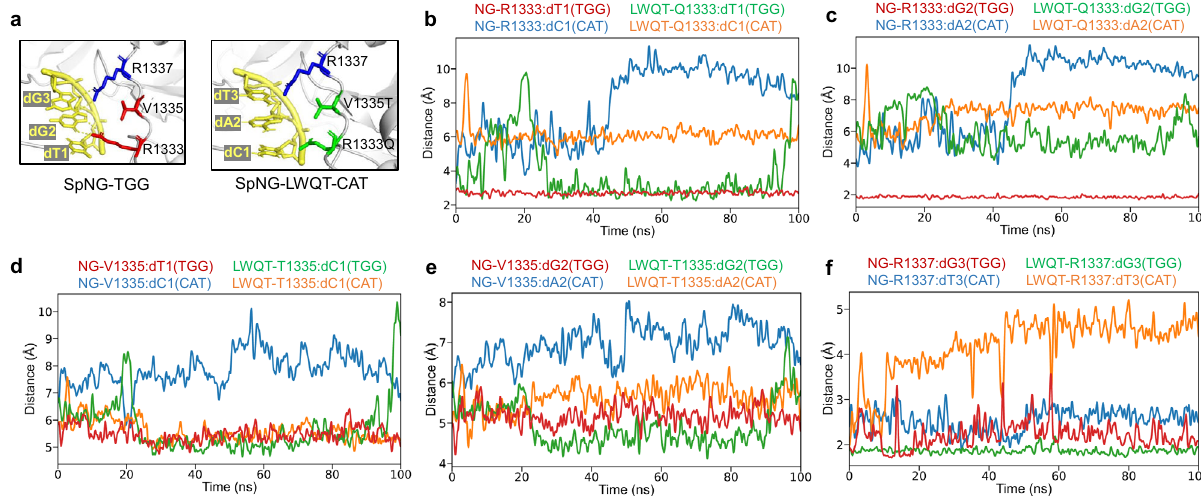
Fig. 4 The minimum distances between amino acids and nucleotides. a Overview of PAM interactions between SpNG (PDB ID: 6AI6) or SpNG-LWQT and 5 ′ -TGG-3 ′ or 5 ′ -CAT-3 ′ PAMs. b The minimum distance between R(Q)1333 and dT(C)1. c The minimum distance between R(Q)1333 and dG(A)2. d The minimum distance between V(T)1335 and dT(C)1. e The minimum distance between V(T)1335 and dG(A)2. f The minimum distance between R1337 and dG(T)3. Red line: SpNG-TGG; blue line, SpNG-CAT; green line, SpNG-LWQT-TGG; yellow line,